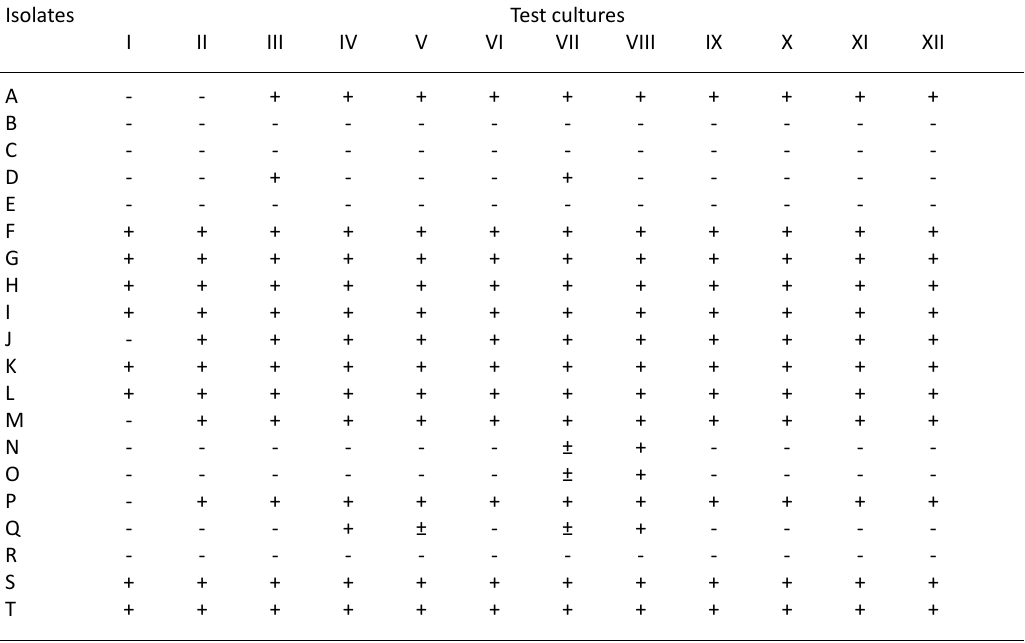
Table 4. Statistical analysis results